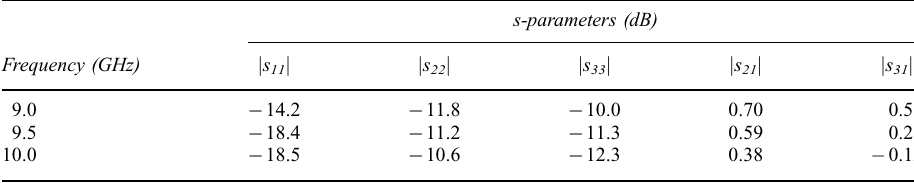
TABLE VI Exact Values of the s-parameters Into the Desired Frequency